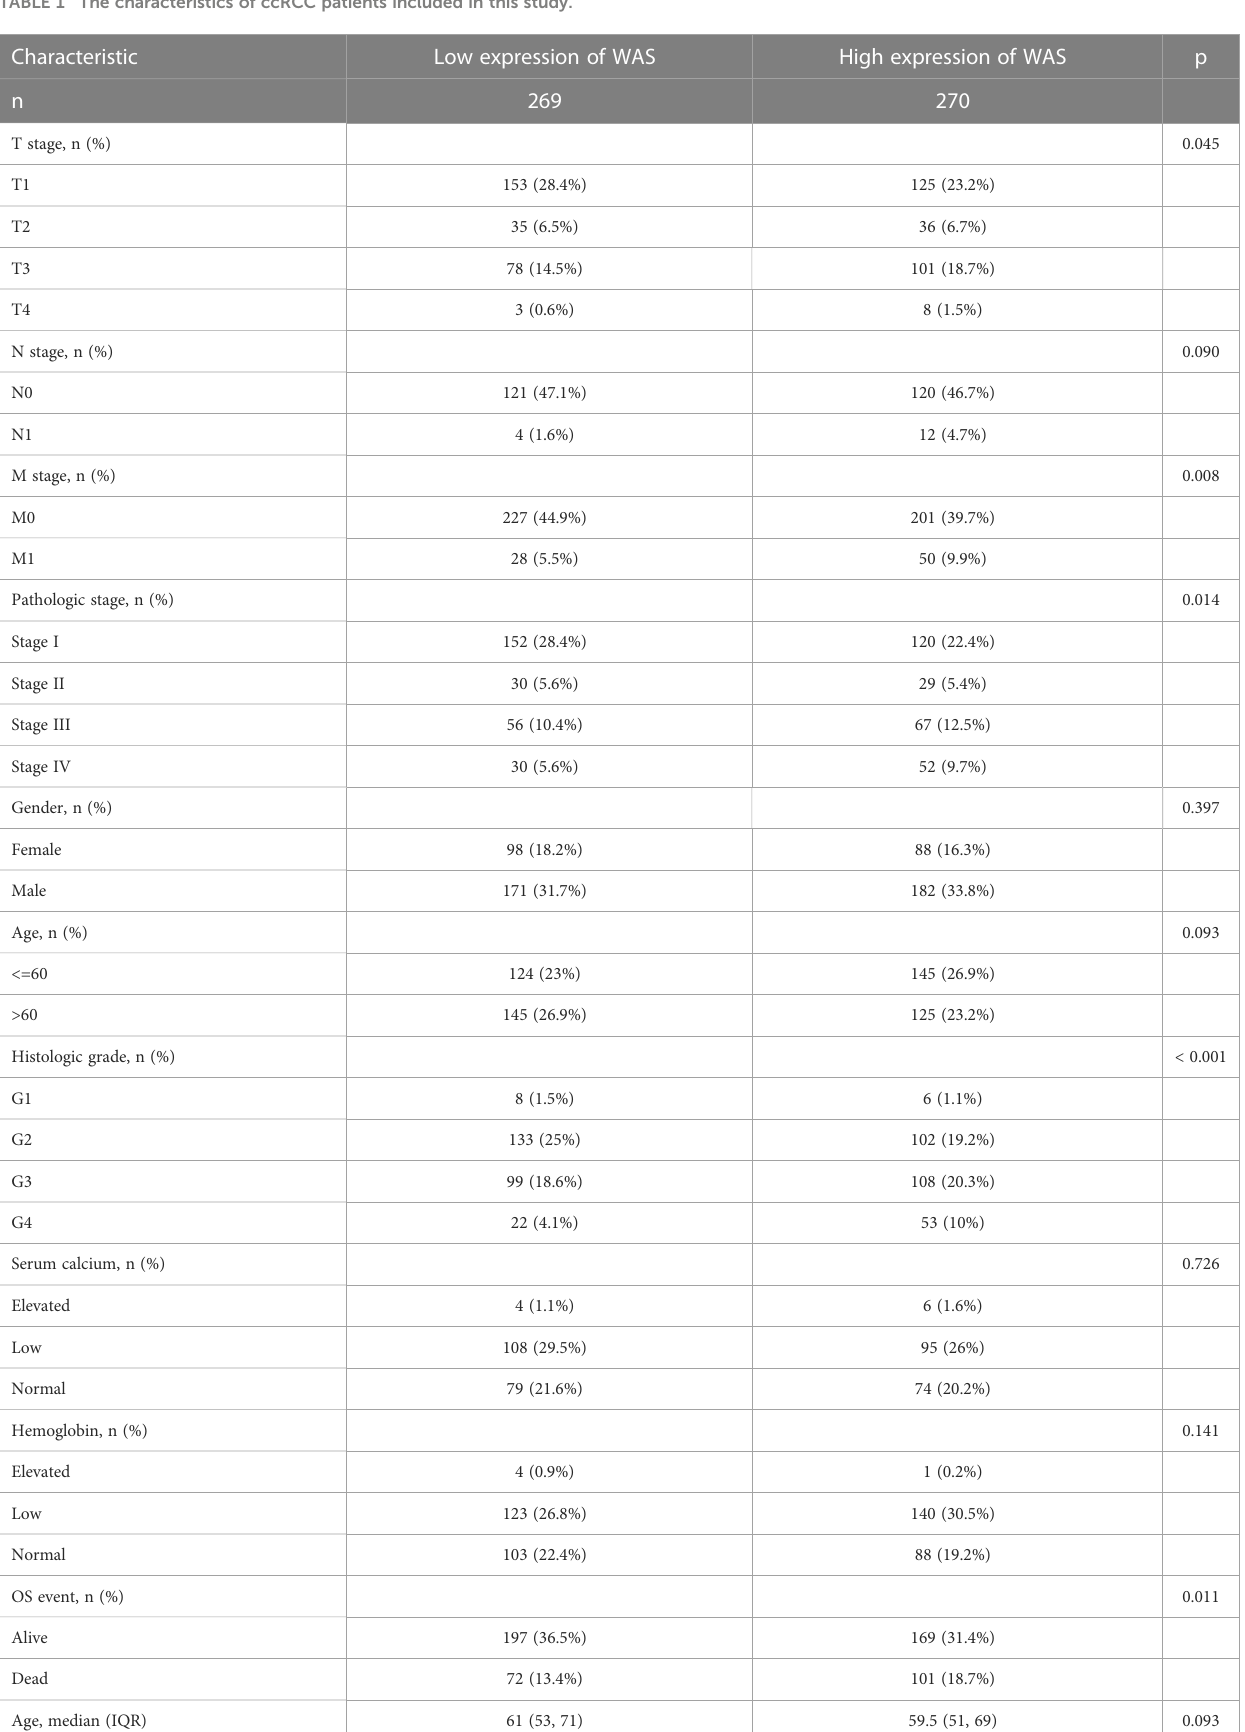
TABLE 1 The characteristics of ccRCC patients included in this study.